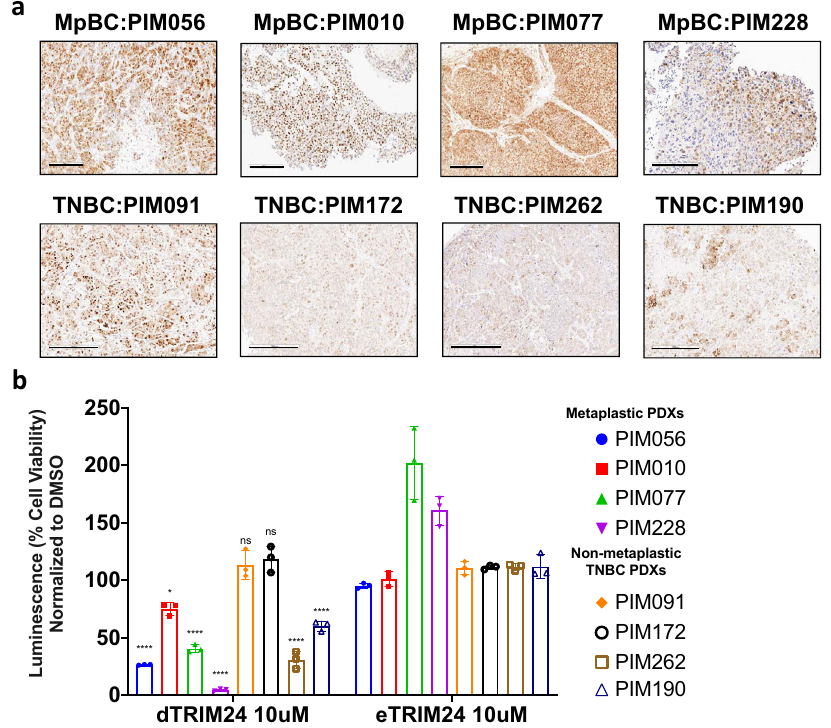
Fig. 7 Human MpBC patient-derived xenografts (PDX) overexpress TRIM24 and show reduced cell viability when treated with a TRIM24 protein degrader. a Representative images of TRIM24 IHC of human MpBC PDXs (PIM056, PIM010, PIM077, and PIM228) compared to control samples, non- MpBC-TNBC PDXs, (PIM091, PIM172, and PIM262). Scale bar = 200 μ M for PIM056, PIM010, and PIM077. 300 μ M for PIM228 and all TNBC PDXs. b Representative graphs show luminescence-based assays of cell viability with TRIM24 degrader (dTRIM24) or negative control eTRIM24 treatment of human MpBC PDX-derived suspension cells compared to TNBC non-metaplastic PDX cell suspensions. The percentage cell viability is calculated by normalizing luminescence to DMSO treatment. Signi fi cance is calculated using ANOVA between eTRIM24 and dTRIM24 of each sample ( n = 3 technical replicates). Data represented as mean ± SEM and p -values are calculated by two-way ANOVA for multiple comparison using Holm-Sidak method (* p = 0.0351, **** p < 0.0001, ns non-signi fi